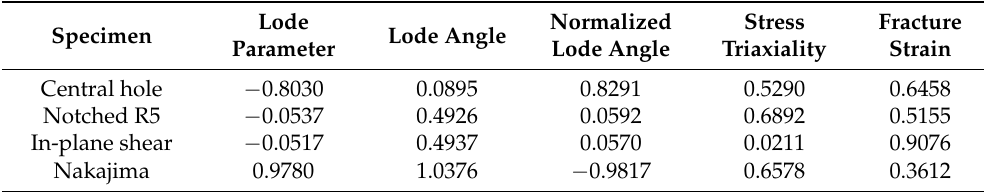
Table 8. Fracture stain, the Lode parameter, and the stress triaxiality obtained by hybrid numerical– experimental approach for martensite specimens.